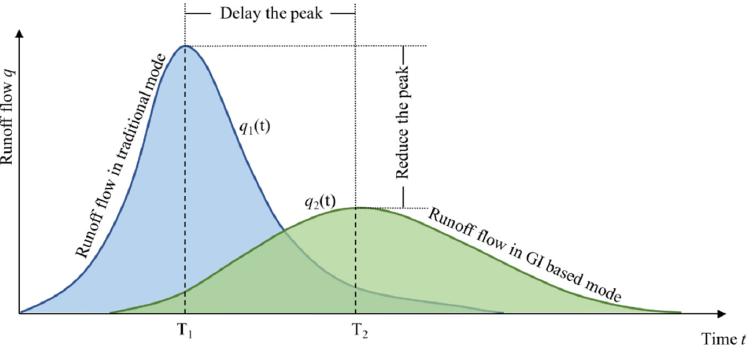
Figure 3. Comparison of the runoff process before and after GI implementation.